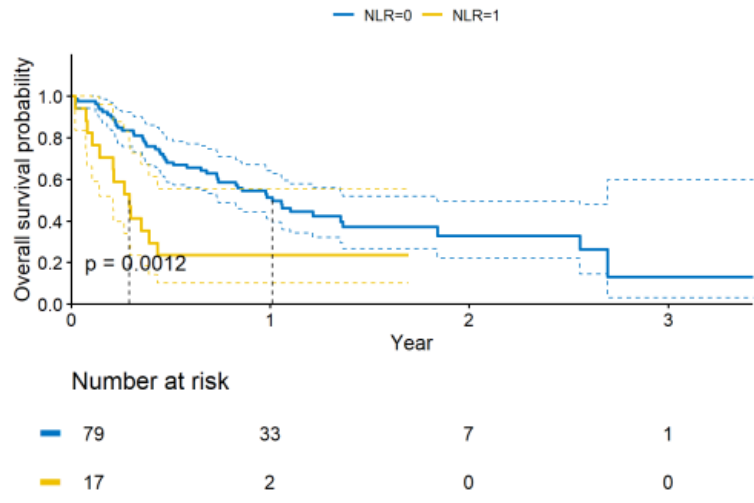
Figure 6. Probability of survival in the entire analyzed group—by NLR.